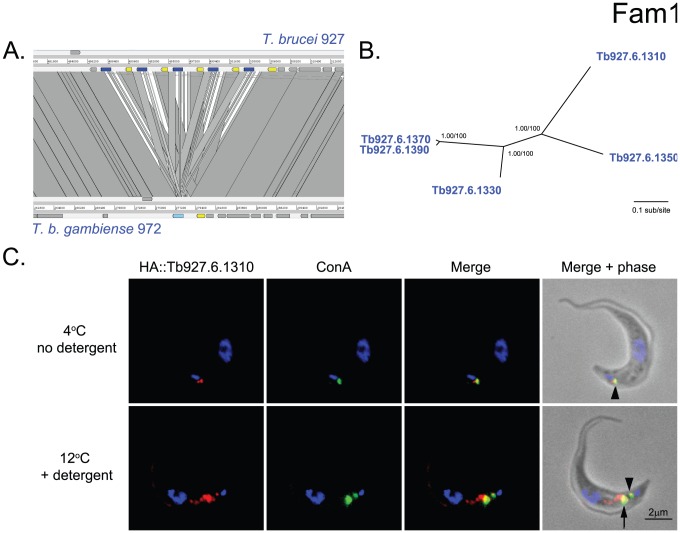
Phylogeny and expression of a T. brucei-specific, VSG-like hypothetical protein (Fam1).
A. Fam1 consists of five, non-identical tandem gene copies at a strand-switch region on chromosome 5, which is unique to T. brucei. B. A Bayesian phylogram estimated from a multiple nucleotide sequence alignment of 1068 characters. The tree is midpoint-rooted. Nodes are supported by posterior probability values and non-parametric bootstraps generated from a maximum likelihood analysis using a GTR+G model. C. Immunofluorescence analysis of Tb927.6.1310 expression in T. brucei. Tb927.6.1310 was N-terminally HA epitope-tagged and expressed in bloodstream-form cells. Cells expressing HA::Tb927.6.1310 were loaded with FITC-concanavalin-A in serum-free media and incubated at either 4°C (upper panel) or 12°C (lower panel). ConA is restricted to the flagellar pocket at the lower temperature, whereas it is transported to, and trapped within, Rab5A positive early endosomes at 12°C. Columns in each panel (from left to right); fluorescent stain of HA epitope tag (red); FITC-ConA fluorescence (green); merged images for fluorescence; merged images from phase and fluorescence. DAPI-stain of the nucleus and kinetoplast is shown in blue. HA::Tb927.6.1310 co-localizes with ConA at the flagellar pocket (indicated with arrow head) and early endosomes (indicated with a whole arrow).